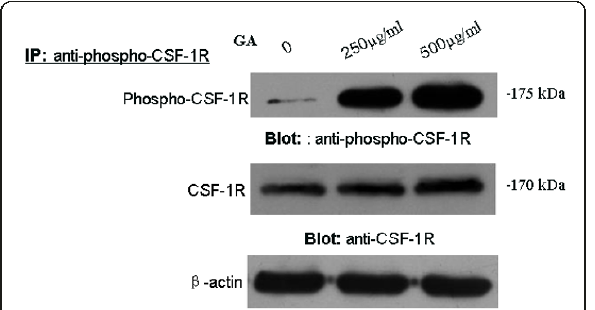
Figure 7 Glycated albumin (GA) induces the up-regulation of CSF-1R and tyrosine-phosphorylation of CSF-1R in purified microglial cells . Microglial cells were incubated with or without GA for 24 h and then subjected to immunoprecipitation (IP) with antibodies against phospho-CSF-1R(Tyr723) and then blot with antibodies against phospho-CSF-1R(Tyr723) or CSF-1R. The expression of b -actin was used as loading